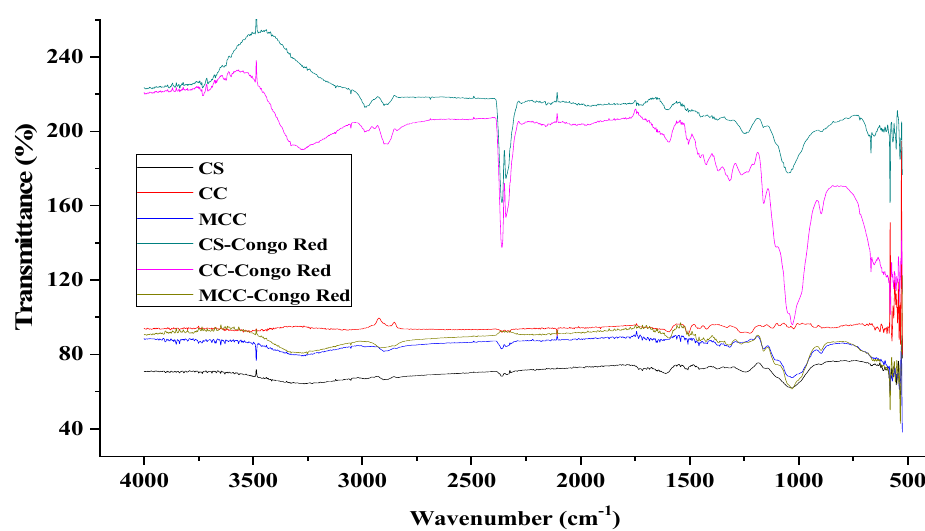
Figure 1. FTIR spectra of coconut shell bioadsorbents before and after Congo red removal.